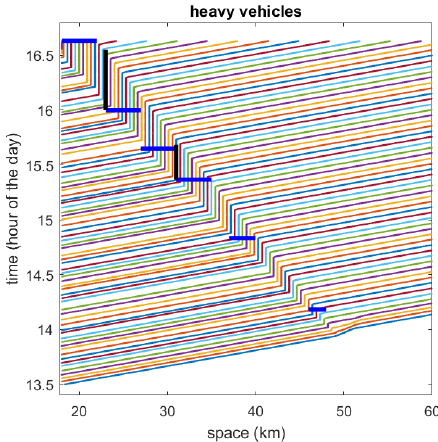
Figure 11. Simulated trajectories obtained with real inflow data as left boundary conditions (not all vehicles are plotted for visualization purposes). Horizontal blue lines and vertical black lines indicate, respectively, the position and the duration of the real queue as measured in the